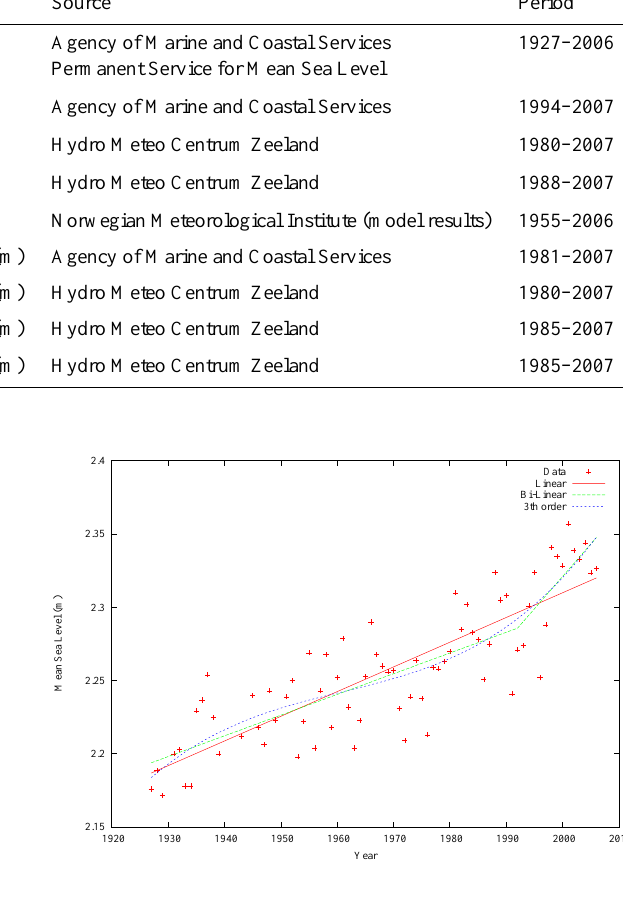
Fig. 2. Time series of yearly mean sea level MSL (TAW) at Oost- ende for the period